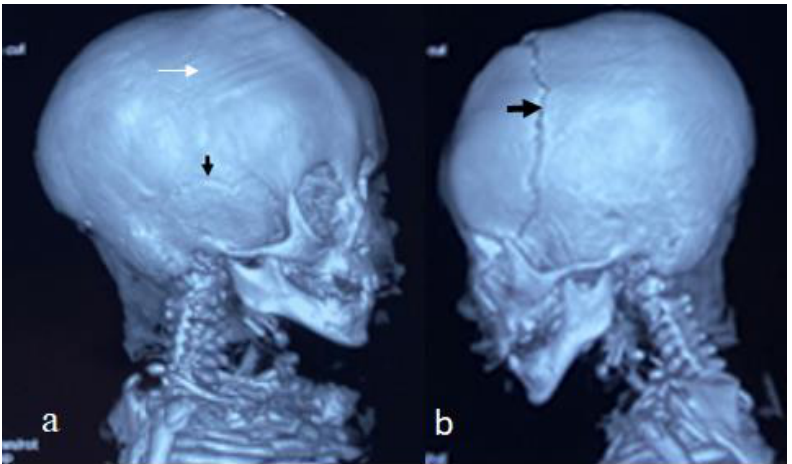
Figure 3. Three-dimensional reconstruction CT scan showed the disproportion in growth between the cranial and facial bones. Apparent closure of the metopic and sagittal sutures led to the development of scaphocephaly. Interestingly, there was a unilateral early closure of the right coronal (white arrow) and early closure of the squamosal sutures, respectively (black arrow), causing the asymmetrical bulging of the central part of the crown ( a ). Three-dimensional reconstruction confirmed the persistence of the left coronal suture (arrow) ( b ).